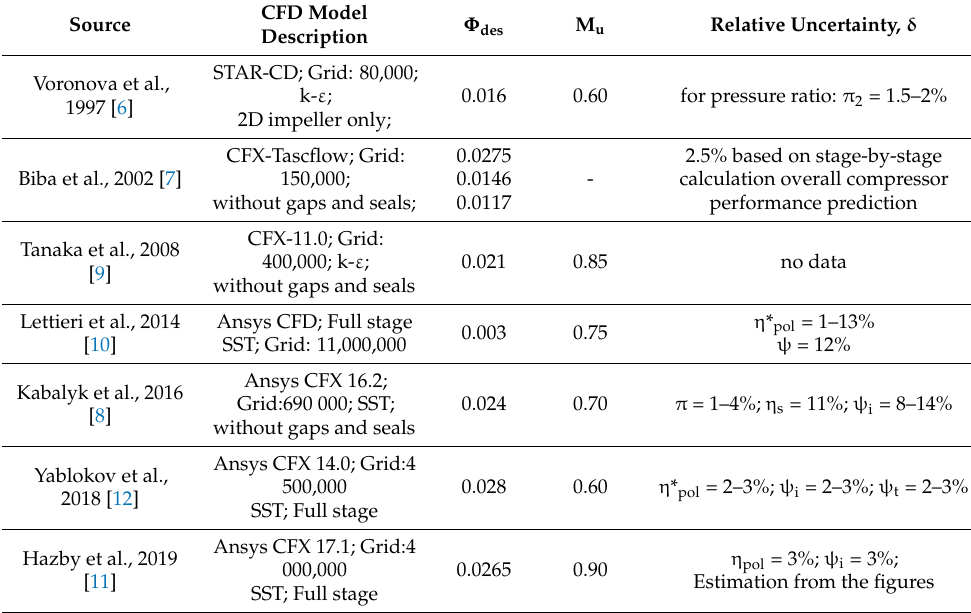
Table 1. The results of the research in the available